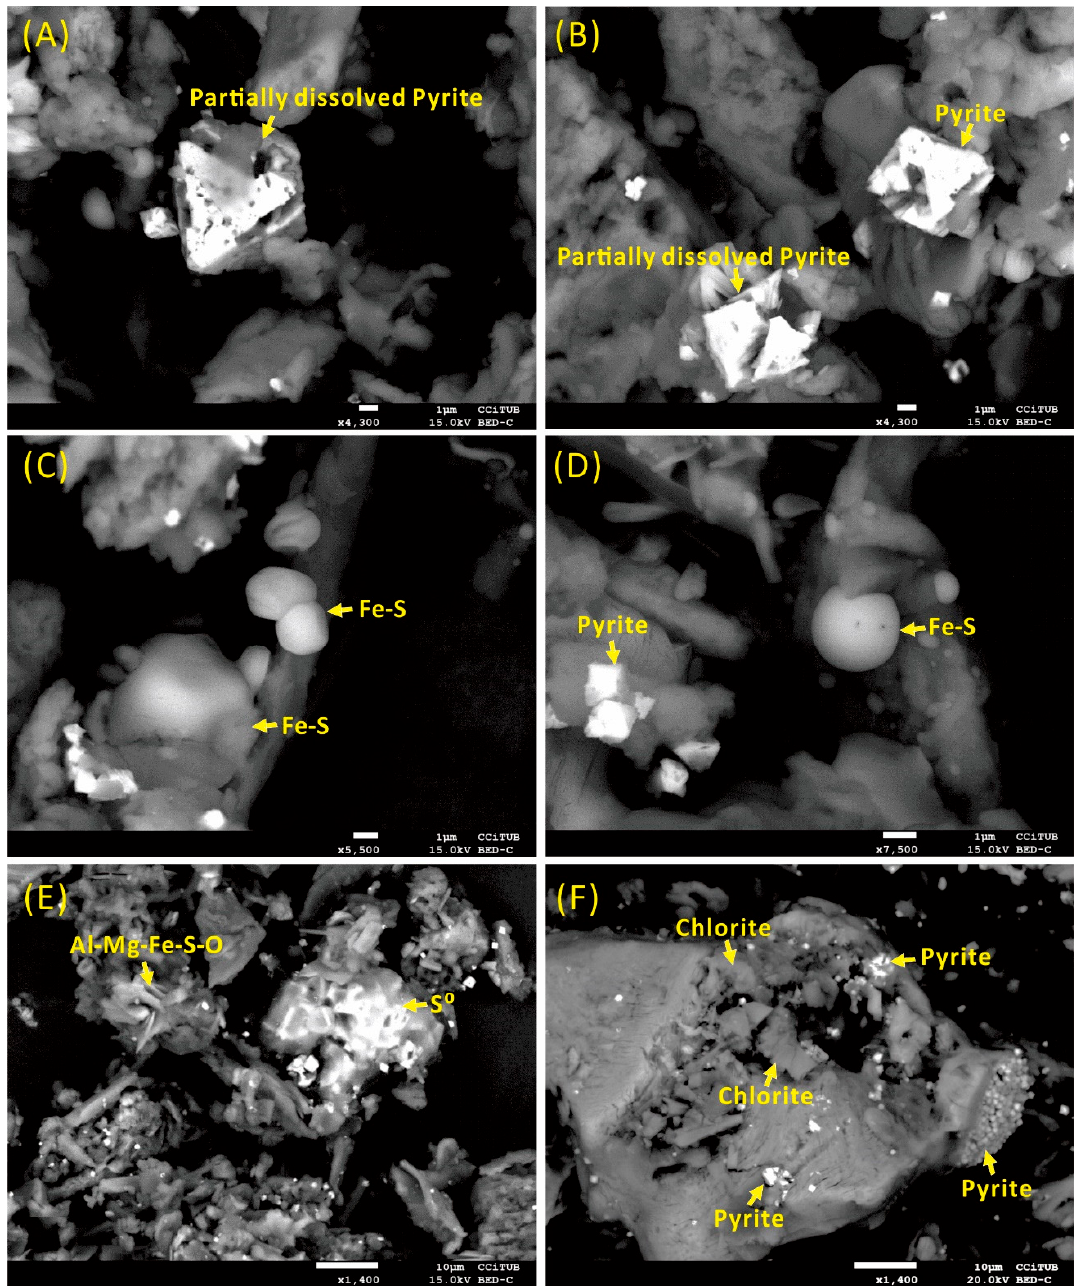
Figure 7. SEM back-scattered electron images of coalified trunk samples from Wulantuga open-pit mine. ( A ), partially dissolved pyrite in sample WLTG-03. ( B ), partially dissolved pyrite and pyrite in sample WLTG-03. ( C ), globular Fe sulfide particles in sample WLTG-03. ( D ), pyrite and globular Fe sulfide particle in sample WLTG-03. ( E ), Al–Mg–Fe sulfate and elemental sulfur in sample WLTG-03. ( F ), chlorite and pyrite in sample WLTG-01.